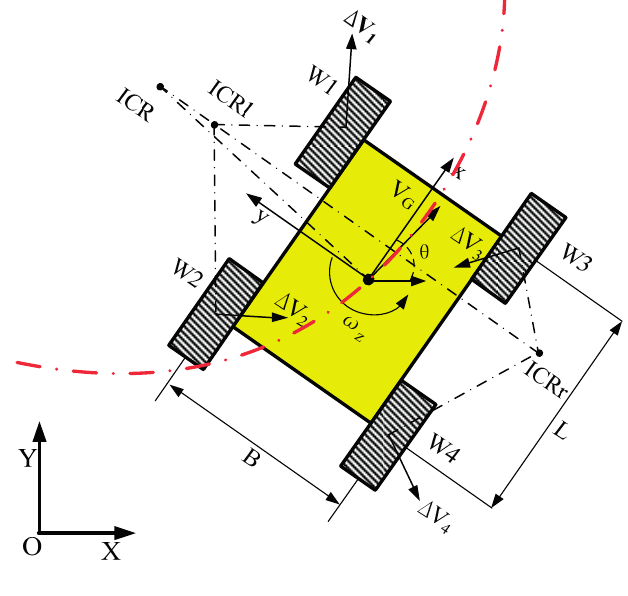
Figure 1. The kinematics schematic of skid-steering mobile